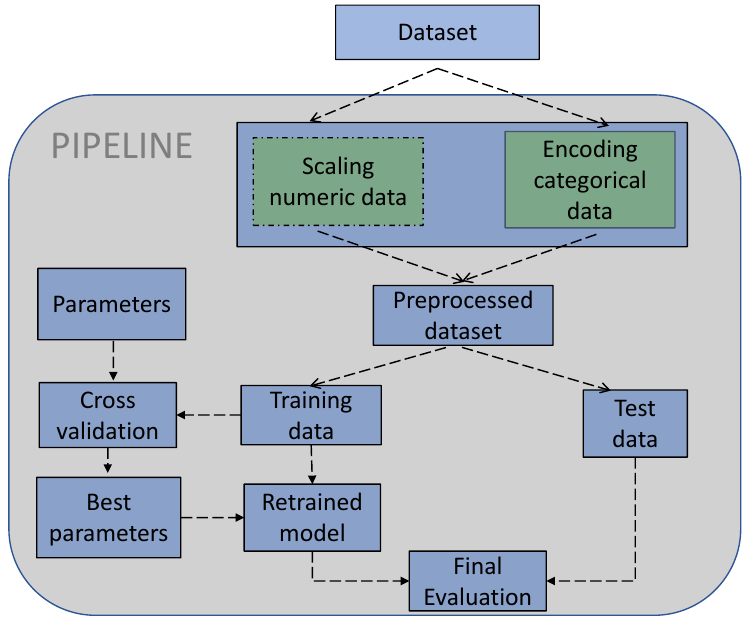
Figure 1. The machine-learning pipeline (symbols with dashed line edges illustrate that that step is not always